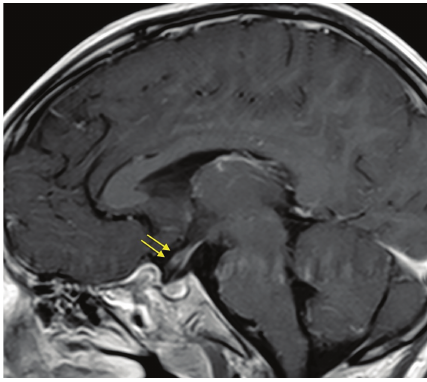
Figure 5: Sagittal post-Gad T1WI FSE. Enhancement of the right optic nerve (yellow arrows).